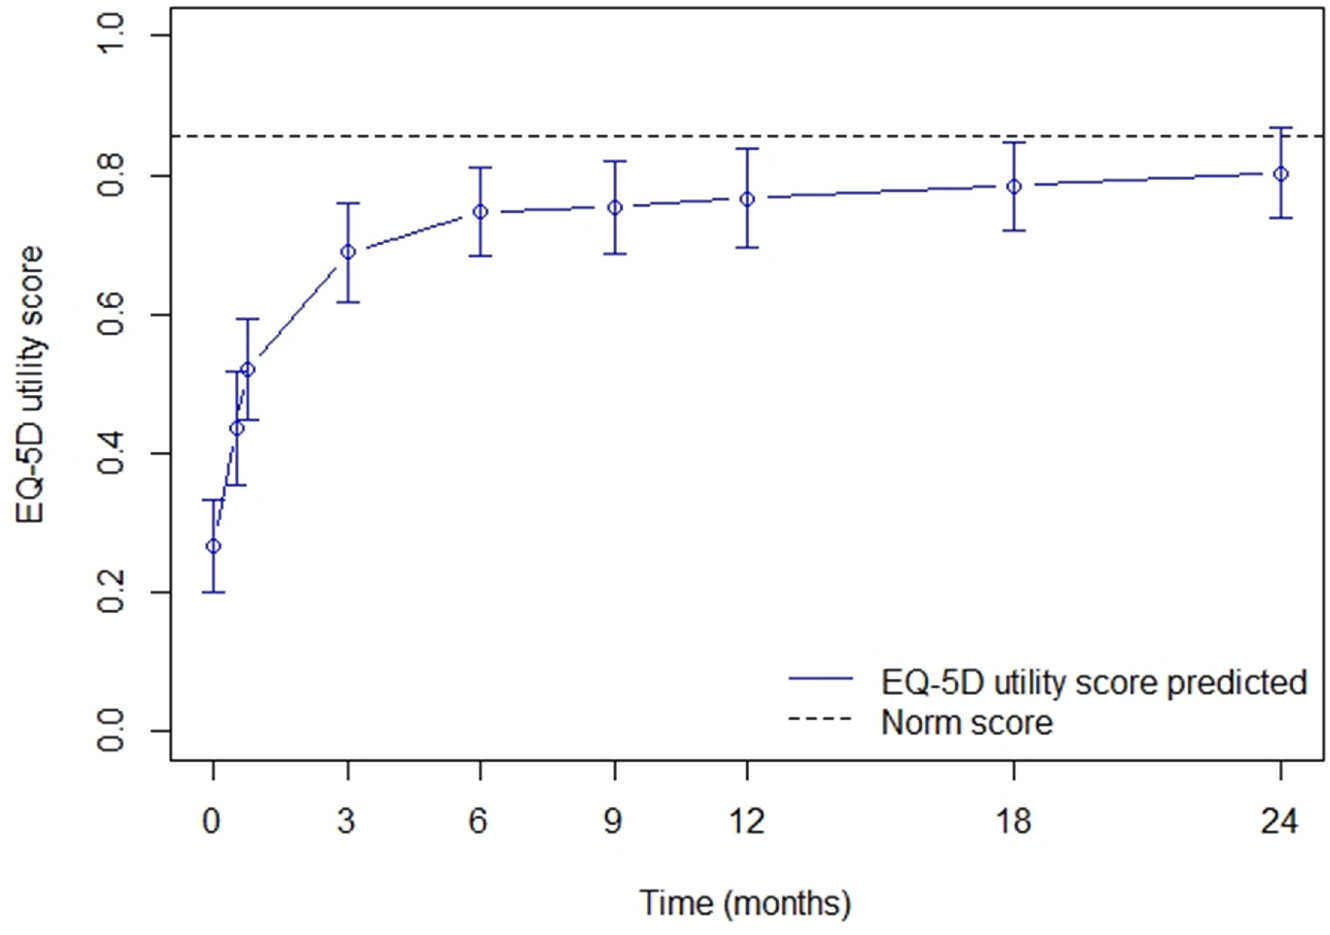
Fig 4. Estimated recovery of HRQL measured by EQ-5D utility scores over time.